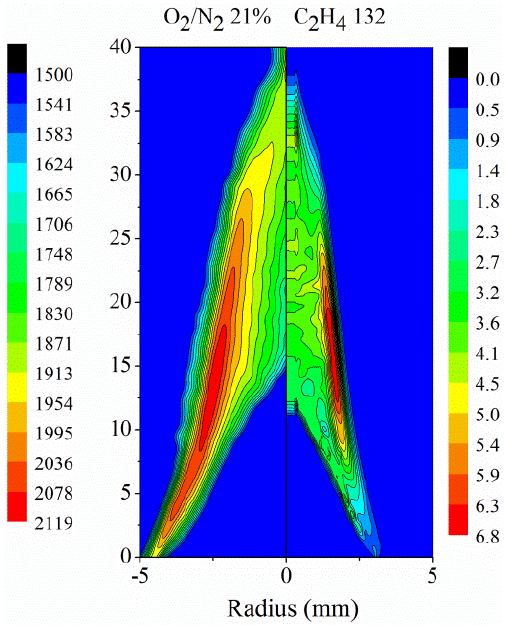
Figure 14. 2-D distributions of temperature T (K) and soot volume fraction (10 − 6 ) for case1. Energies 2017 , 10 , 750